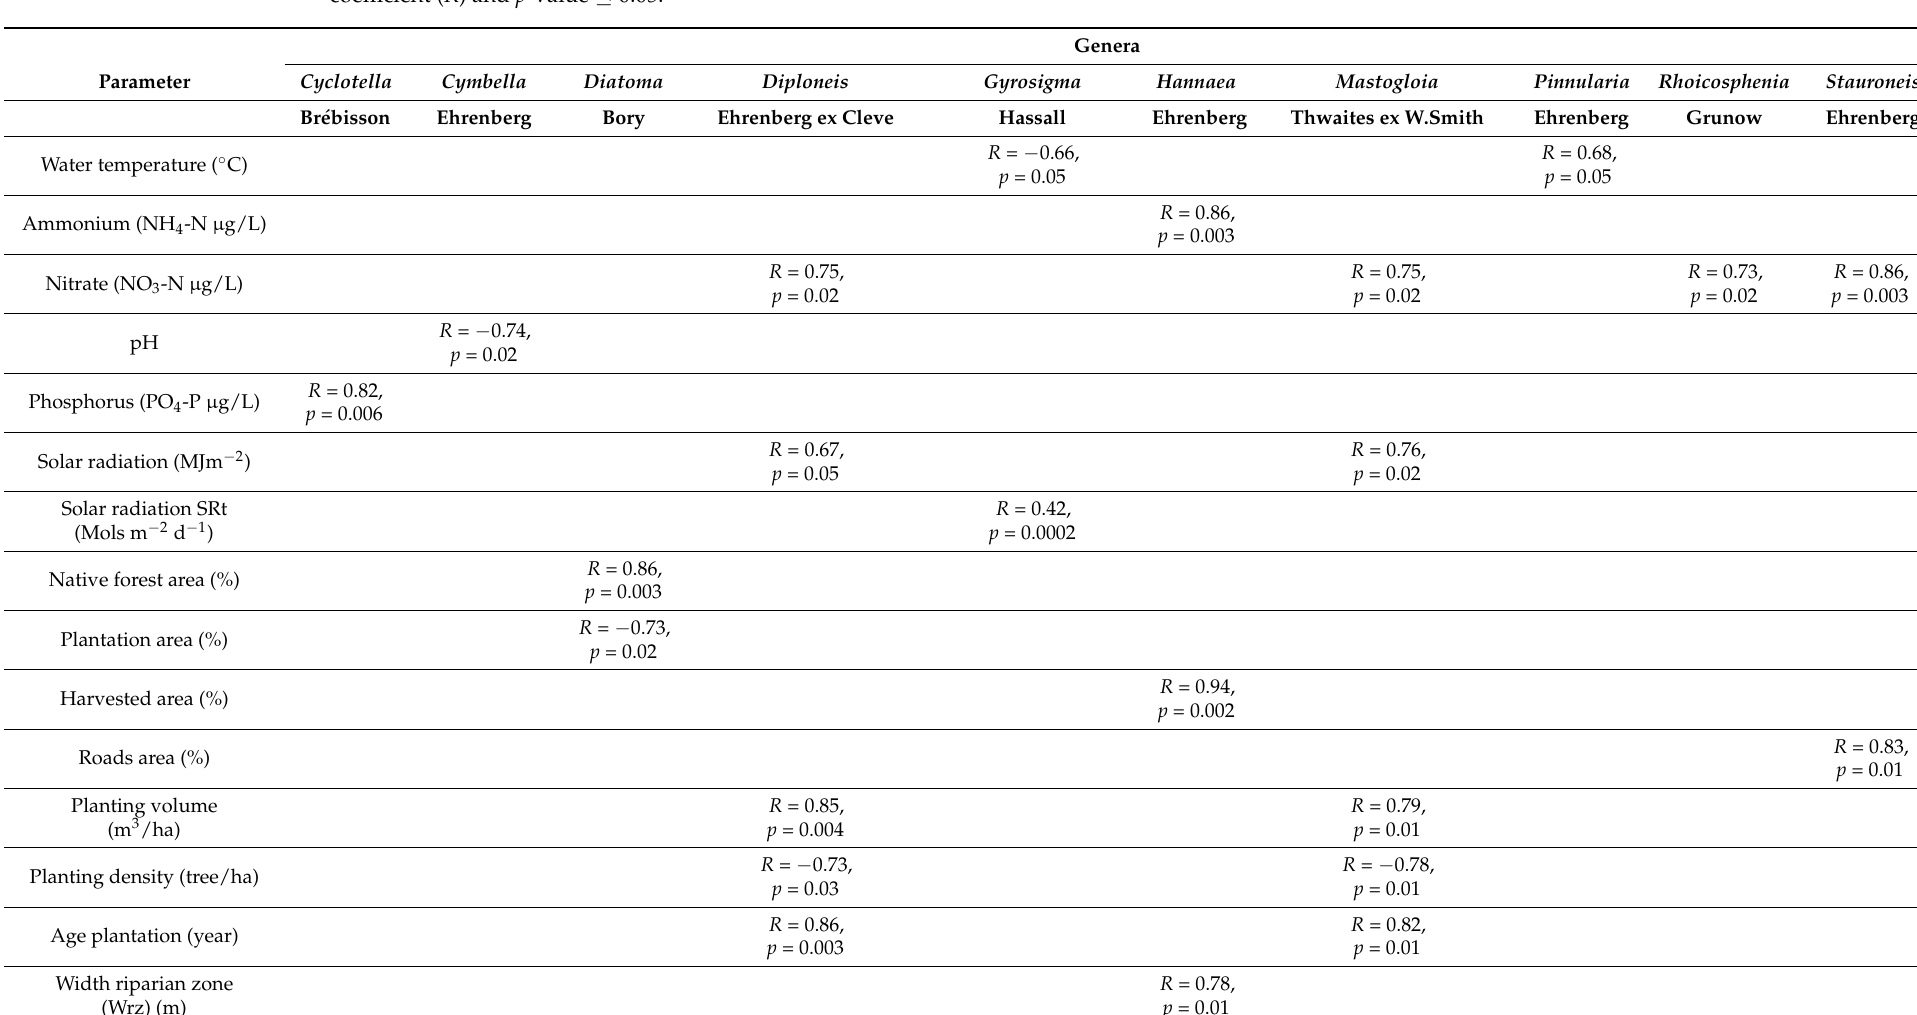
Table 3. Linear regression of genera described in Table 2, at the 9 sampling stations against the physicochemical parameters and forest cover data, linear correlation coefficient ( R ) and p -value ≤